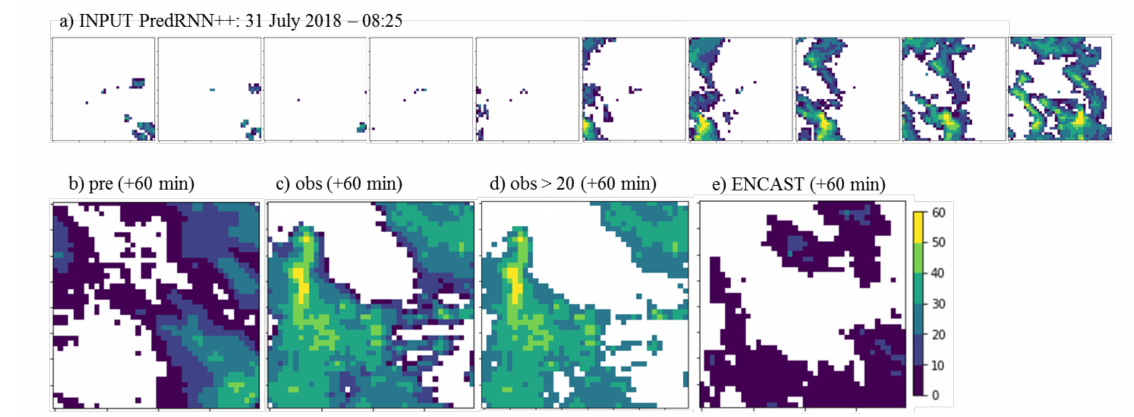
Figure 3. Prediction for 8:25 on 31 July 2018: ( a ) 10 input frames of PredRNN ++ ; ( b ) 1-h prediction of PredRNN ++ ; ( c ) observed reflectivity, ground truth of ( b ); ( d ) observed reflectivity greater than 20 dBZ, used as “truth” compared to ( e ); ( e ) 1-h prediction of Ensemble NowCASTing